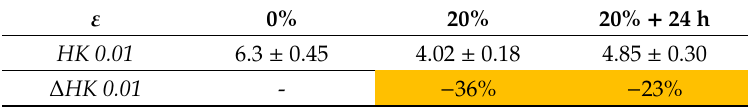
Table 6. Results of surface free energy tests for deformed polymers.